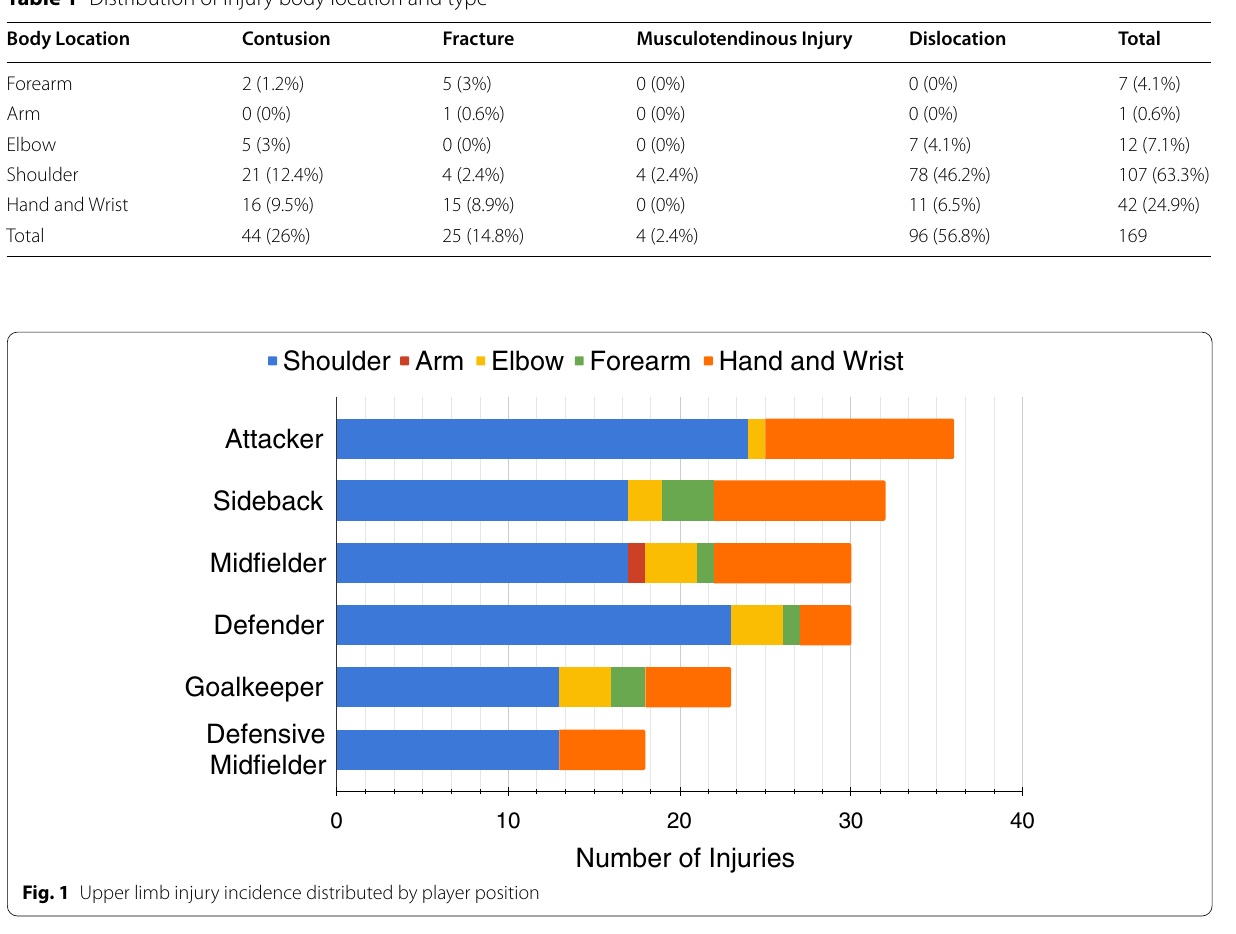
Table 1 Distribution of injury body location and type